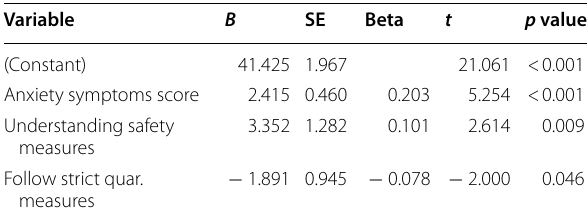
Table 6 Predicting variables of SDSC by linear stepwise regression analysis